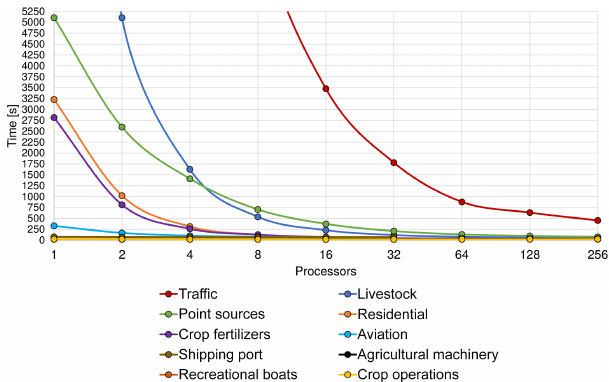
Figure 9. Computational times (s) obtained from the scalability test performed with HERMESv3_BU over Spain. Each line represents the amount of time needed to complete the emission estimation pro- cess of each pollutant sector as a function of the number of proces- sors used ( x axis, represented with a base 2 logarithmic